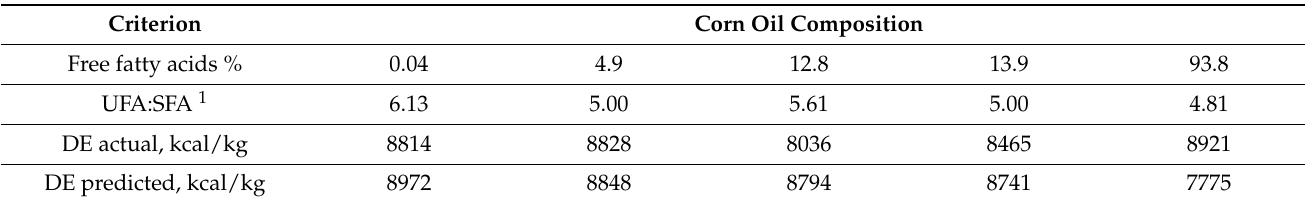
Table 9. Comparison of in vivo determined digestible energy (DE) content in distillers corn oil with variable free fatty acid content and predicted DE content using equations from [151] for young pigs (adapted from [150]).